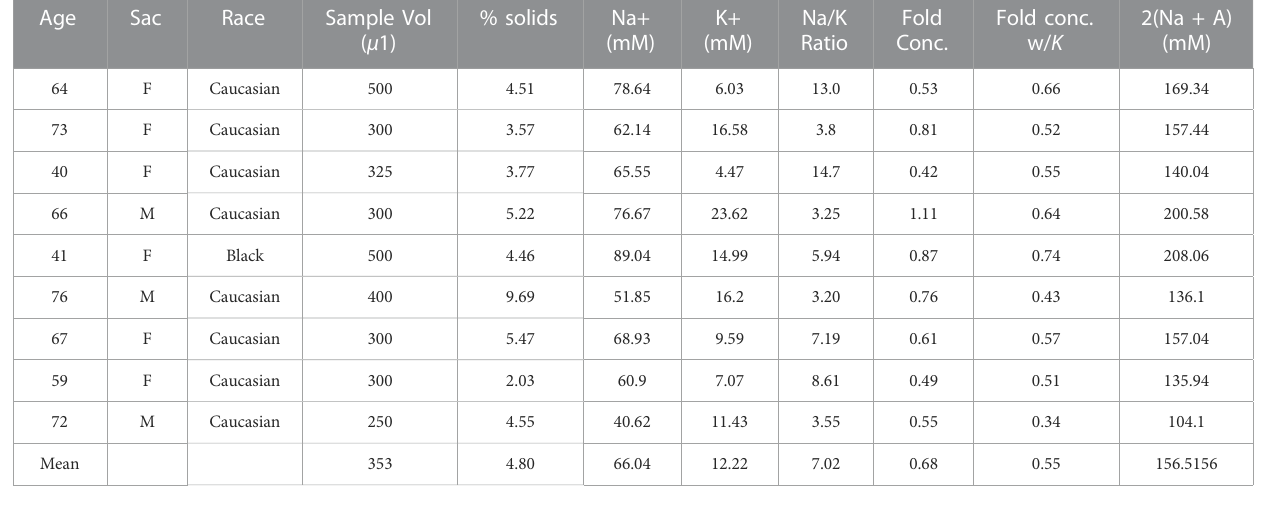
TABLE3Tonicitycorrectedsamplesbywayofsaltaddition(ADD) — 9ETTsampleswerefoundtohavesimilarlysub-physiologicalNa + andK + concentrations(~50% of